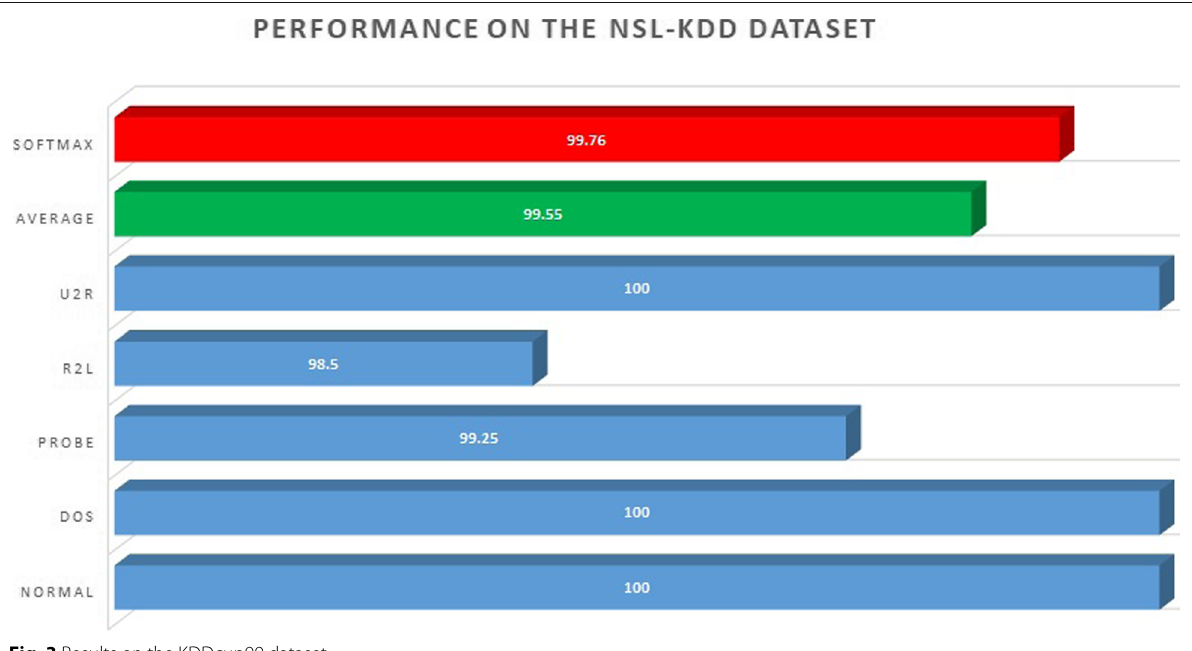
Fig. 3 Results on the KDDcup99 dataset